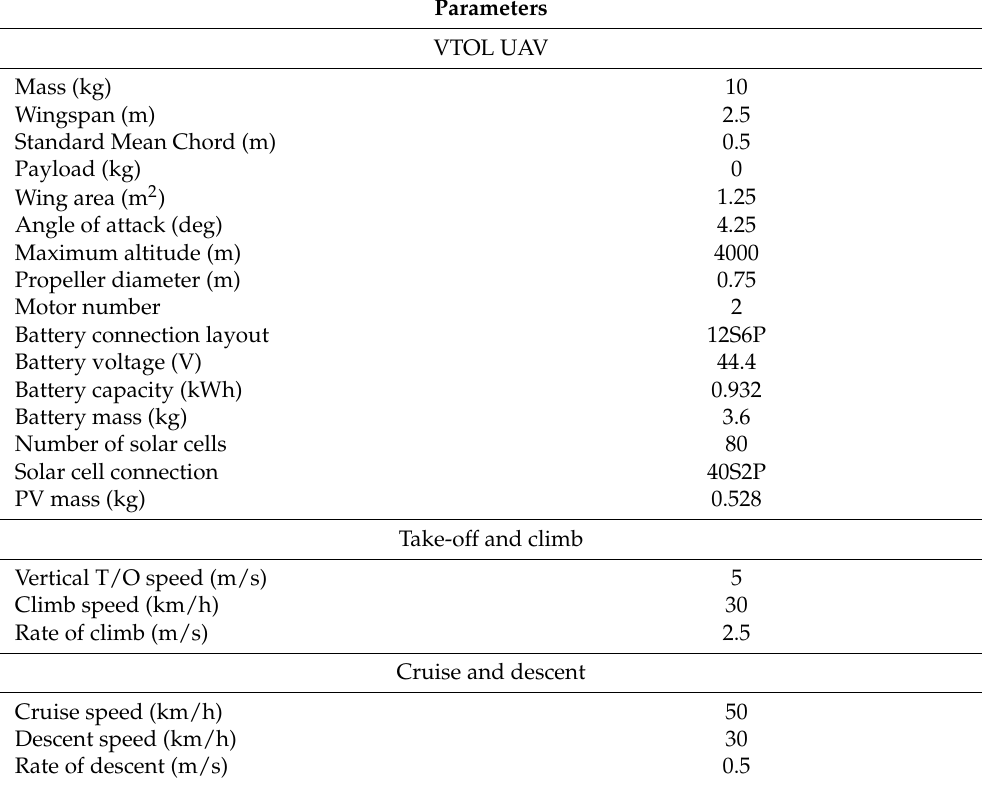
Table 1. Parameters of the designed VTOL and mission.